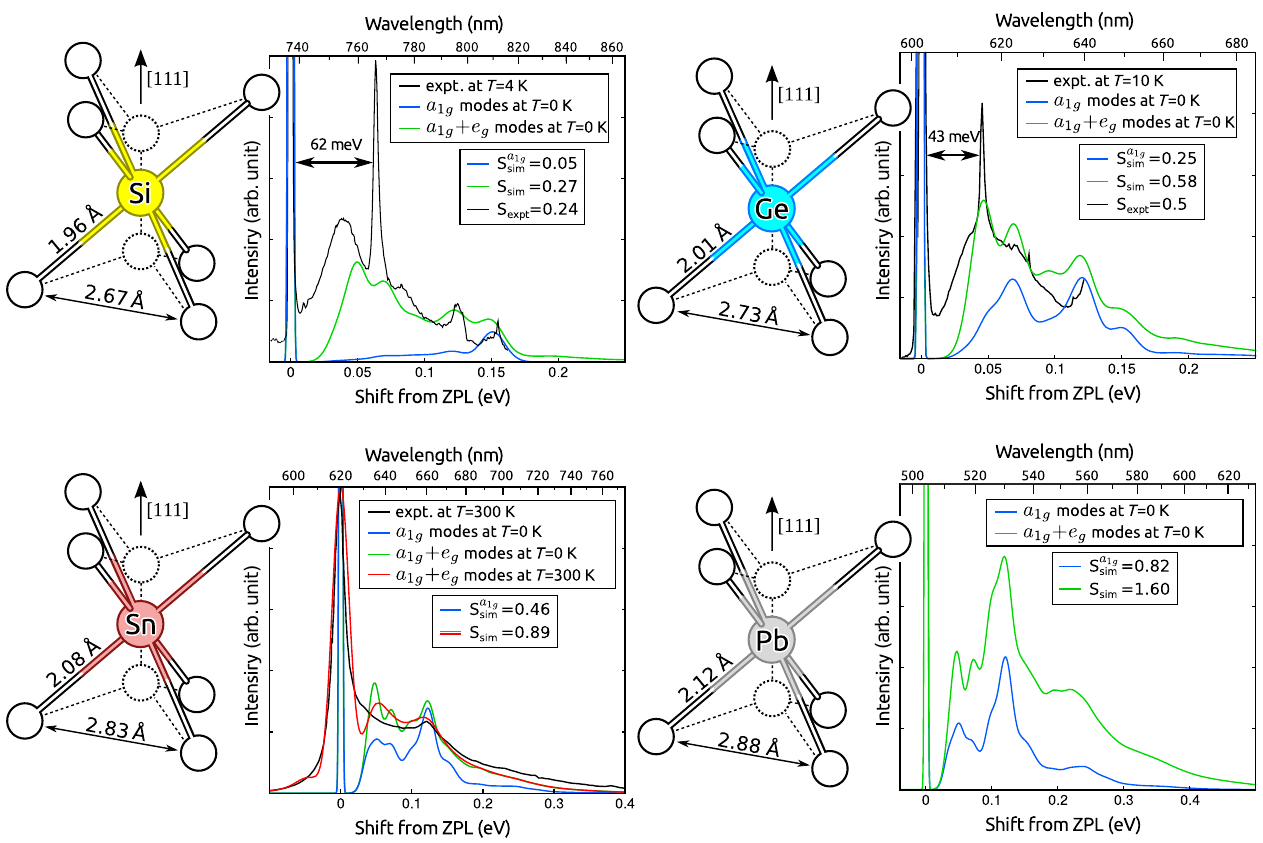
FIG. 4. Experimental and theoretically predicted luminescence line shapes of X V ð − Þ complexes. The red, green, and blue curves are theoretical predictions with HR theory, while the black lines are the actual experimental data for SiV ð − Þ and GeV ð − Þ . The blue curves contain only the effect of totally symmetric a 1 phonons, whereas the green curves add the contribution of e phonons that appear due to g g the Jahn-Teller nature of the electronic states. The experimental curve for SiV ð − Þ and GeV ð − Þ is taken from Refs. [11,25], respectively. For SnV ð − Þ , we use the 620.3-nm PL spectrum that has been recently recorded in Sn-implanted diamond sample at room temperature (Ref. [34]). We show the room temperature theoretical spectrum for SnV in the red plot. We set the linewidth of ZPL to match with the experimental data as our present method cannot determine the ZPL broadening. S values are the calculated HR factors taken from our simulations (sim.) or experiments